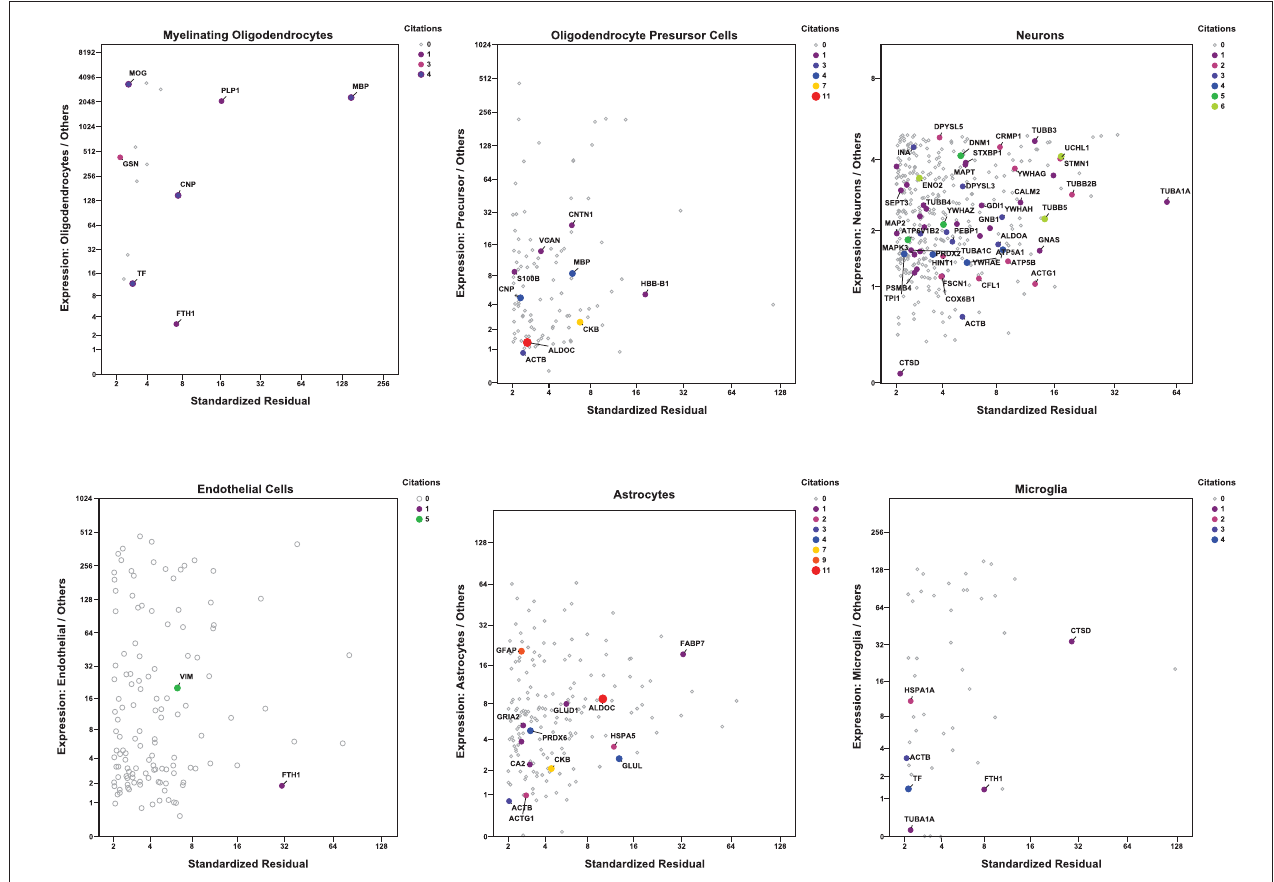
FIGURE 2 | Multiple regression was performed and plotted as in Figure 1C, except that only data points with standardized residuals > 2 are shown. The color of the symbols represents the number of proteomic studies in which the level of each protein was found differentially expressed in brain tissue from individuals with schizophrenia ( Table 1 ). Only genes for proteins cited at least once are labeled. Because of their biological relationship, MO expression was not included as an independent variable in the regression of OPC, and OPC was not included in the regression of